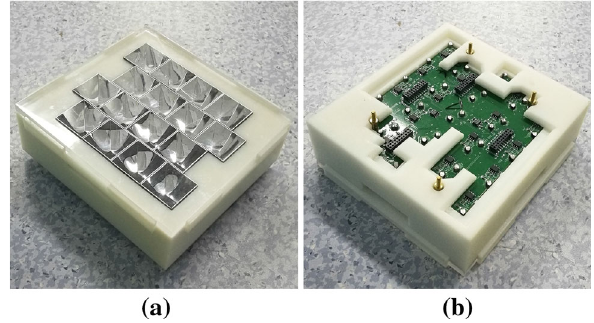
Fig. 16 The funnels-PAB adhesion jig, viewed from above ( a ) and below ( b ). The adhesive used is LOCTITE (cid:2) E-120HP. The jigs